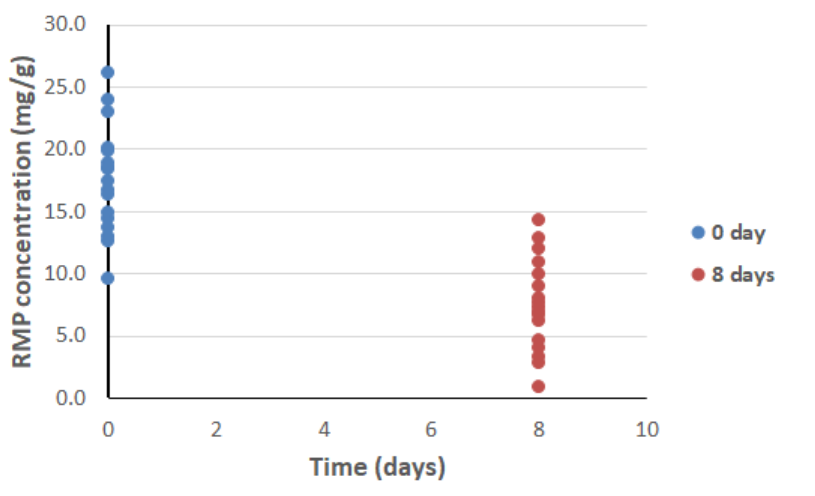
Figure 9. Accelerated RMP stability study of drug-loaded SNEDDSs.